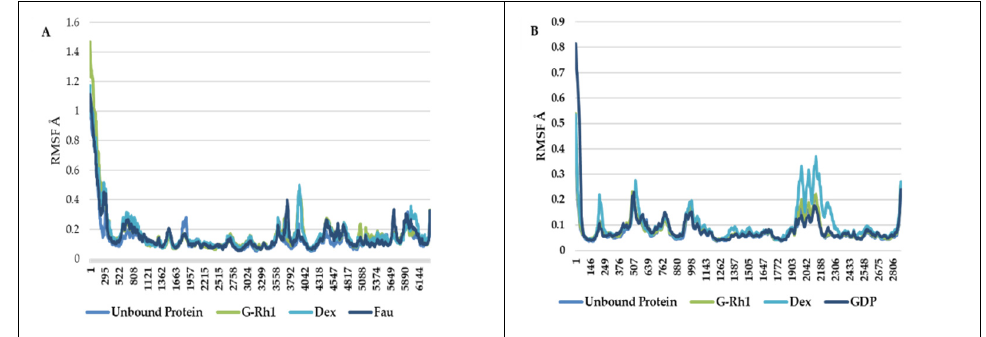
Figure 5 . RMSF of ginsenosides Rh1 and control (Dexamethasone, Fausidil) in complex with ( A ) ROCK1 and ( B ) G-Rh1 and control (Dexamethasone, GDP) in complex with RhoA as a function of MD simulation time.